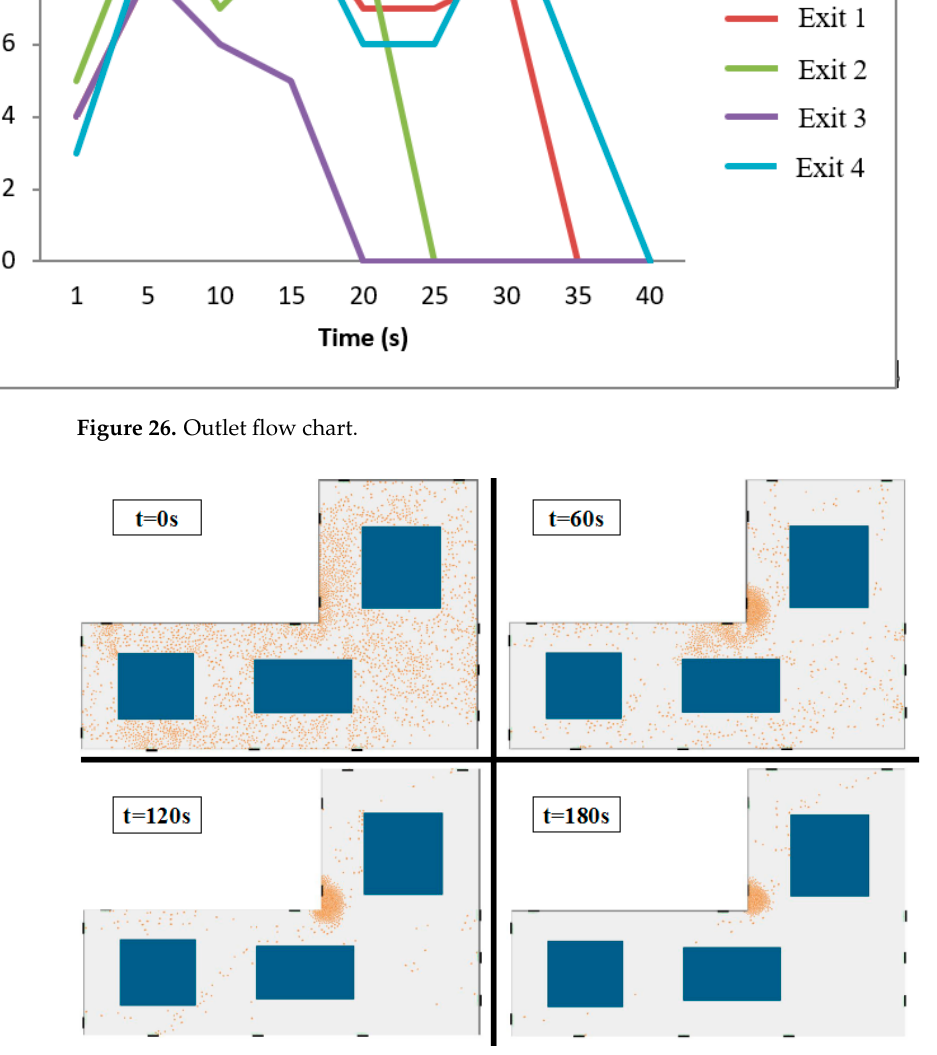
Figure 26. Outlet flow chart.